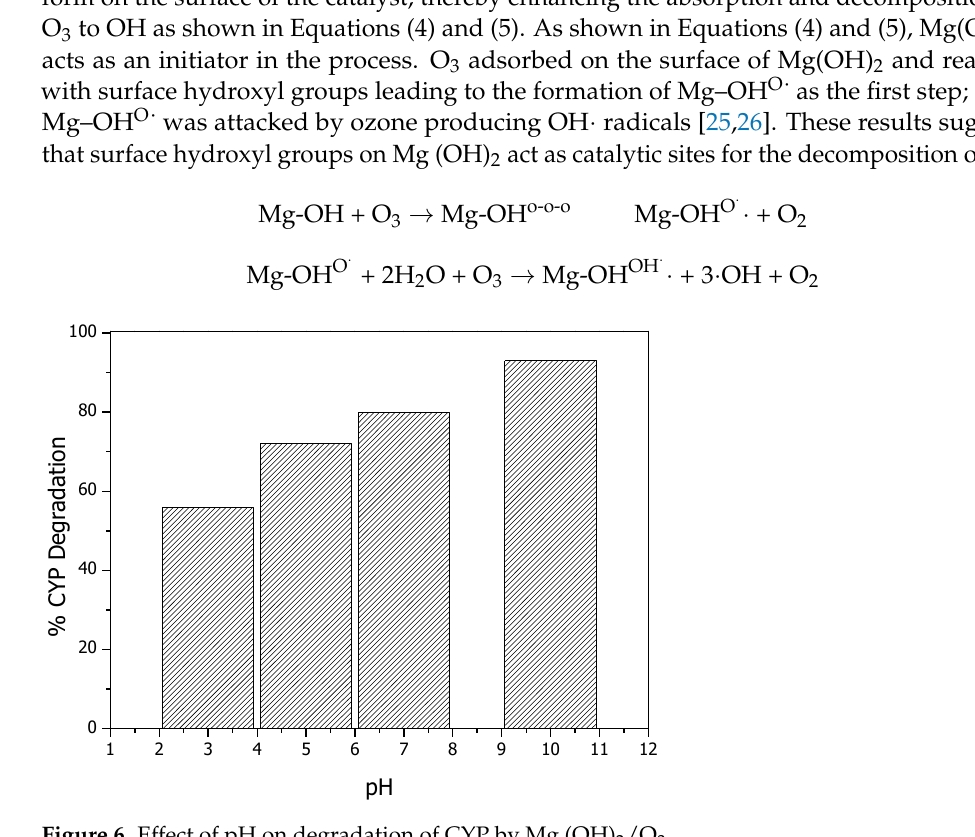
Figure 6. Effect of pH on degradation of CYP by Mg (OH) 2 /O